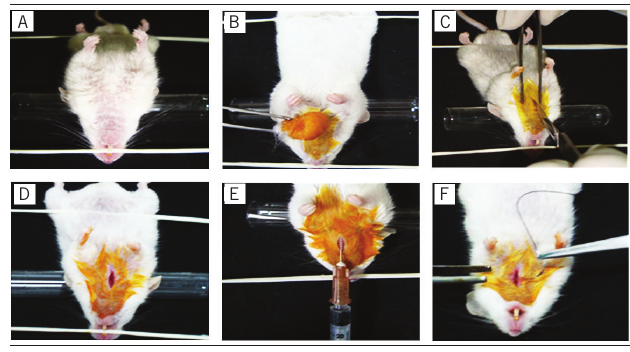
Figure 1 − Puncture tracheotomy in BALB/c lineage mice A) mouse in the supine position; B) asepsis of the cervical region; C and D) incision of the skin; E) puncture and inoculation; F) skin